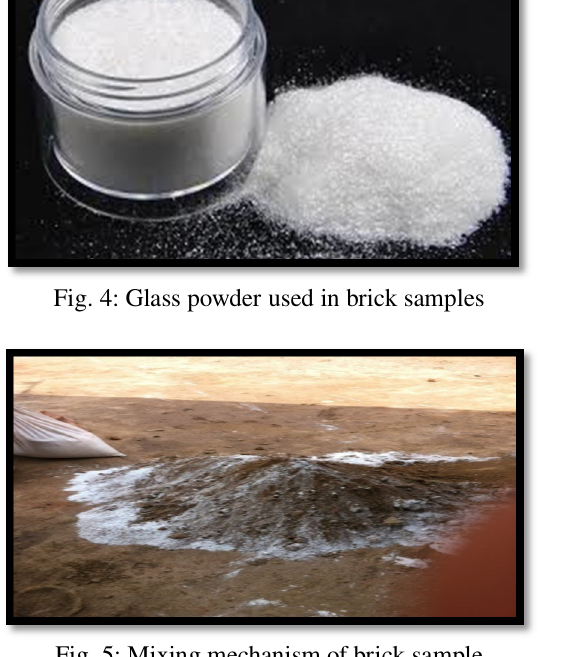
Fig. 5: Mixing mechanism of brick sample preparations